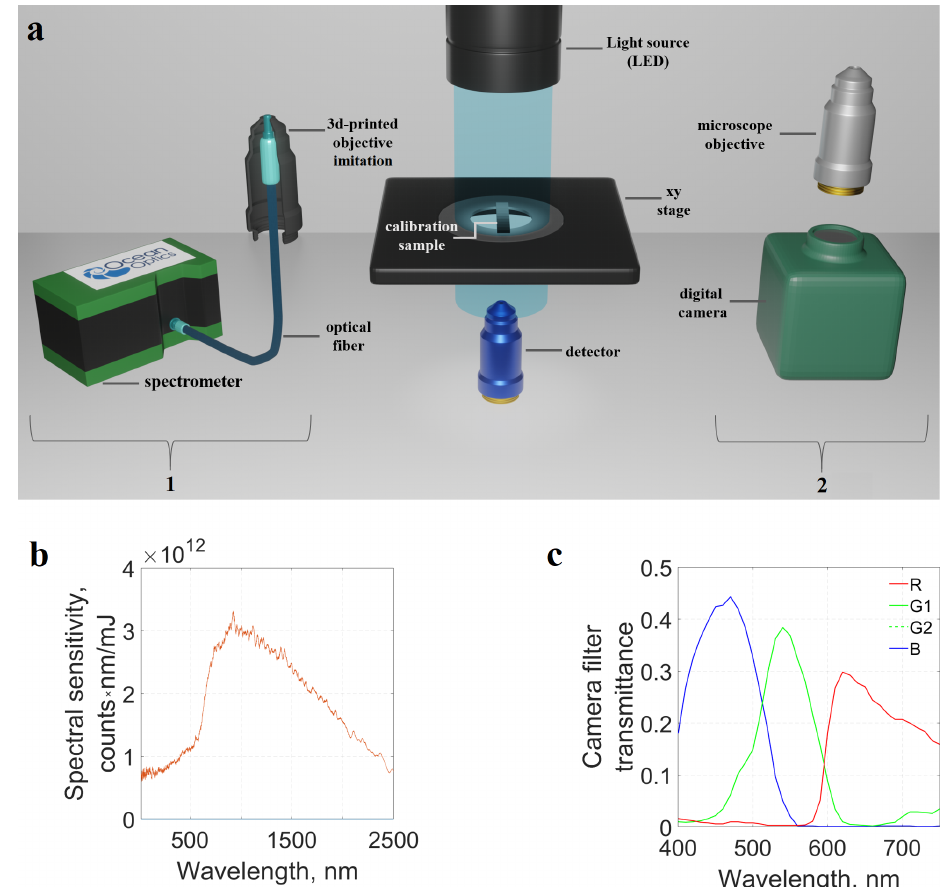
Figure 2. ( a ) The scheme of the measuring apparatus for calibration of the light microscope. 1. A fiber of the optical spectrophotometer placed into a plastic imitation of the microscope objective– arrangement for measurement of the microscope light source spectra after passing through the calibration sample. 2. A real microscope objective and a digital camera as the main part of the arrangement for acquisition of the calibration digital images of the linear step filter. ( b ) Spectral characteristics of an optical fiber spectrophotometer. The response of the Ocean Optics USB 4000 VIS-NIR-ES spectrometer with a fibre P400-1-UV-VIS after illumination by a NIST calibrated lamp. ( c ) Spectral characteristics of a color digital microscope camera. The declared spectra of the Bayer mask filters for a Kodak KAI-16000 camera